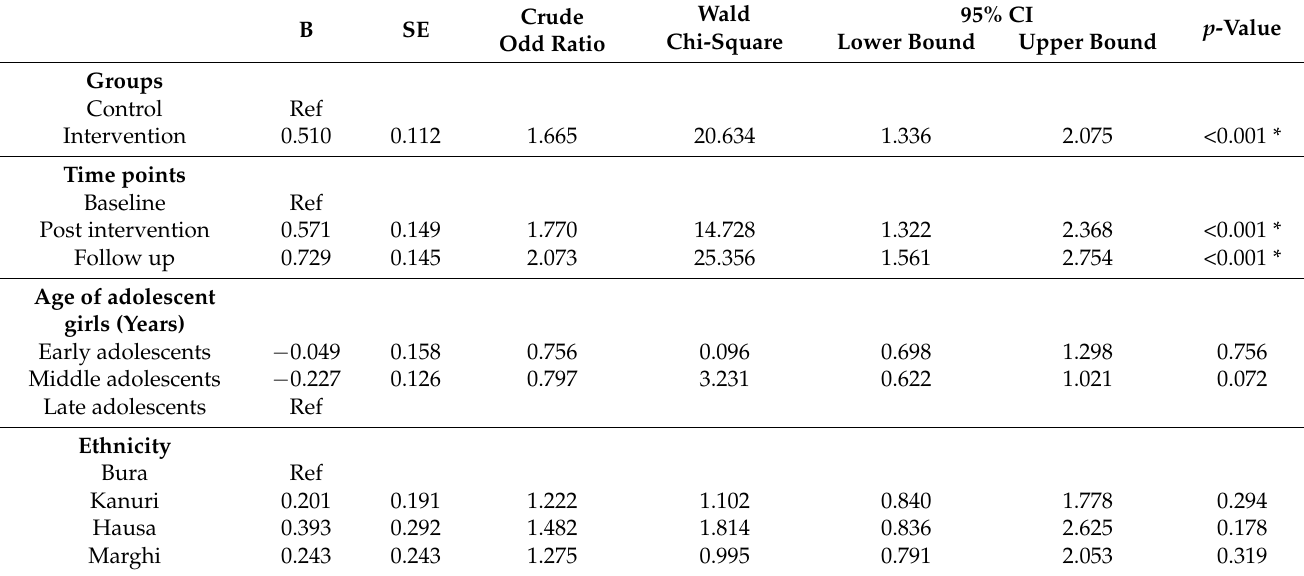
Table 5. List of each factor on WASH practice using generalised estimating